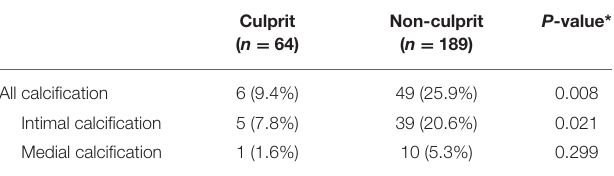
TABLE 4 | Association between calcification patterns and culprit